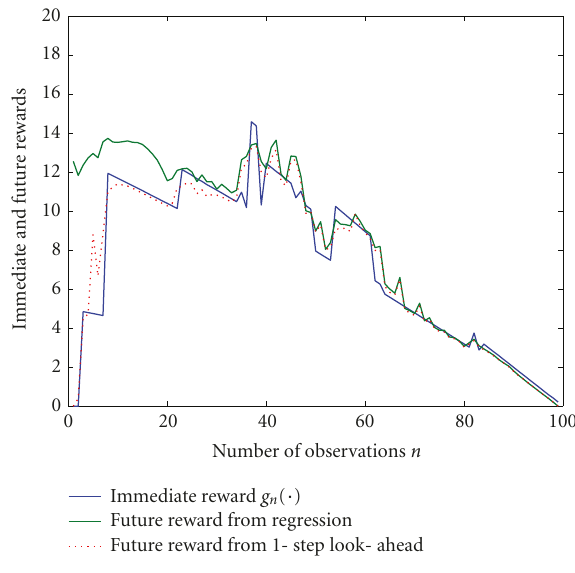
Figure 2: A sample path of reward